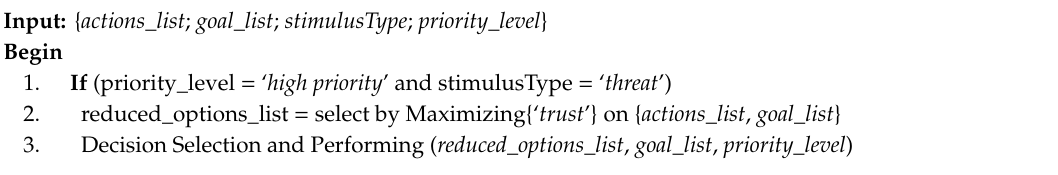
Algorithm 3 Analysis of Decision